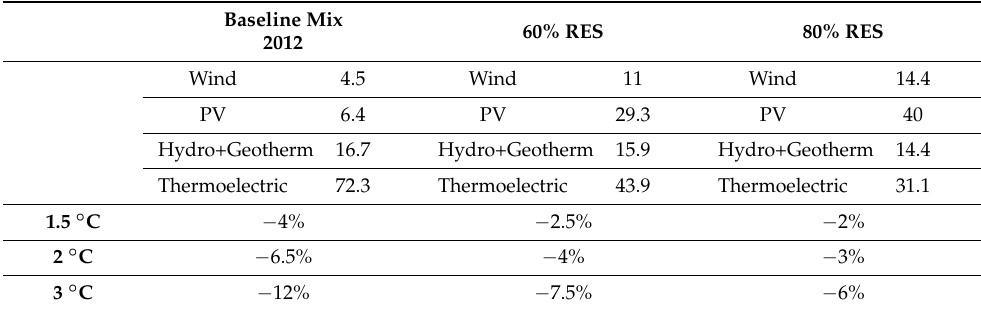
Table 2. Scenarios for the energy mix (the share of technology subsectors is expressed in %) and the change in electricity generation for the Italian case study in 2050